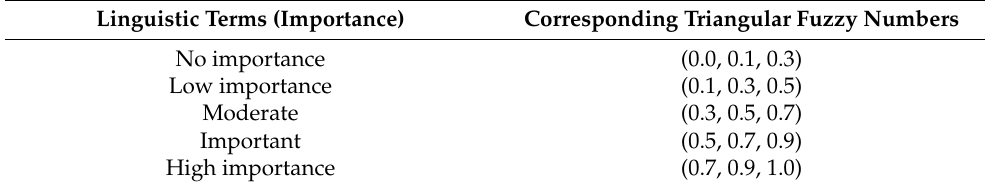
Table 1. Triangular fuzzy numbers linguistic